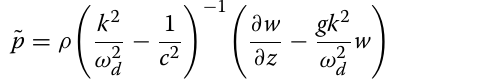
between the vertical displacement and pressure pertur- bation were used in derivation of the boundary condition (24). To model AGW field, wave Eq. (22) was solved numeri- cally at 0 z < H with the initial conditions ≤